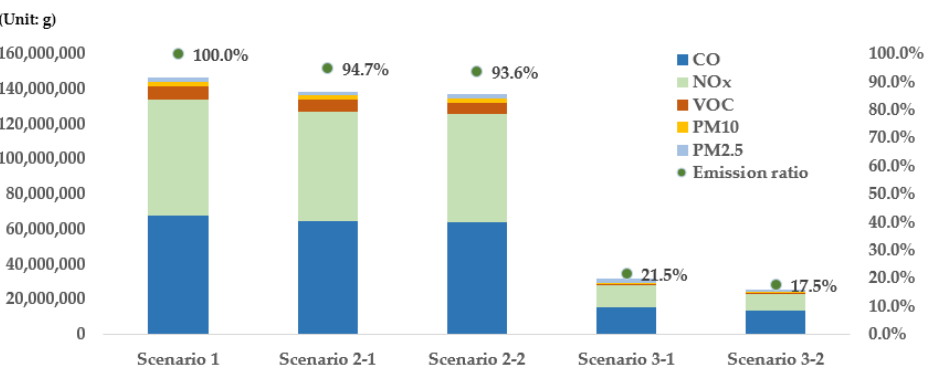
Figure 15. Vehicle emissions and emissions ratio by product. Table 2. Vehicle emissions and reduction efficiency by product.